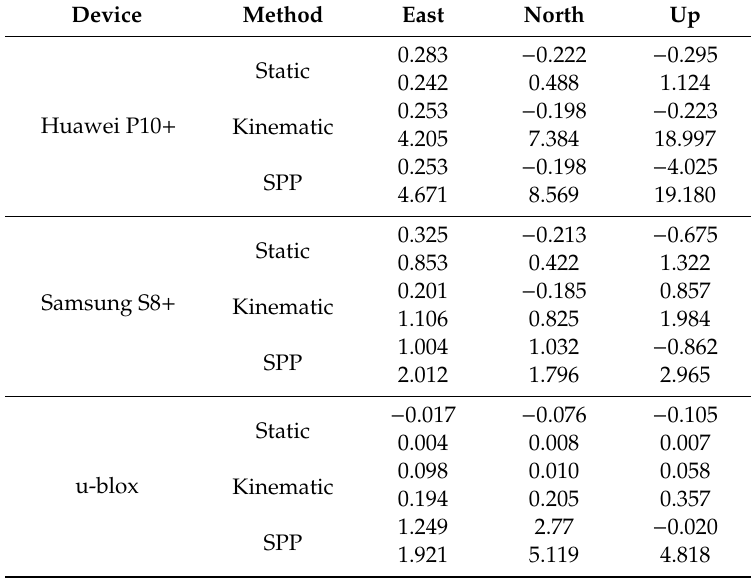
Table 9. Accuracy (upper line for each method) and precision (lower line for each method) results considering a session length of 30 min. All results exceeding a threshold of 3 m are highlighted inside the table.